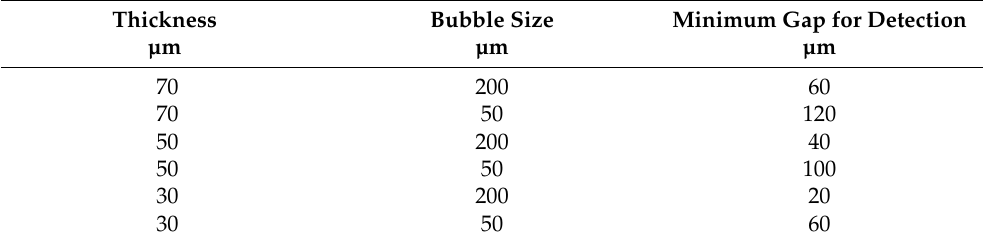
Table 2. Meshing of the